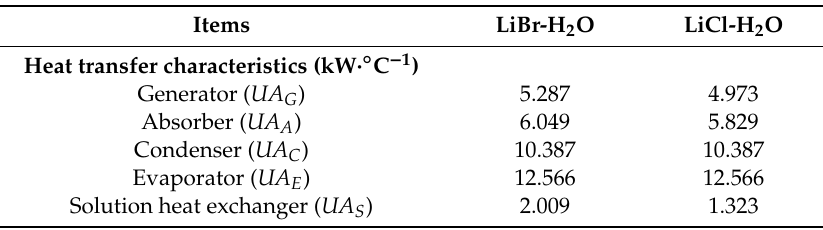
Figure 14. Variations of the exit temperatures of the internal and external fluids with hot water inlet temperature for the LiBr-H 2 O absorption chiller.